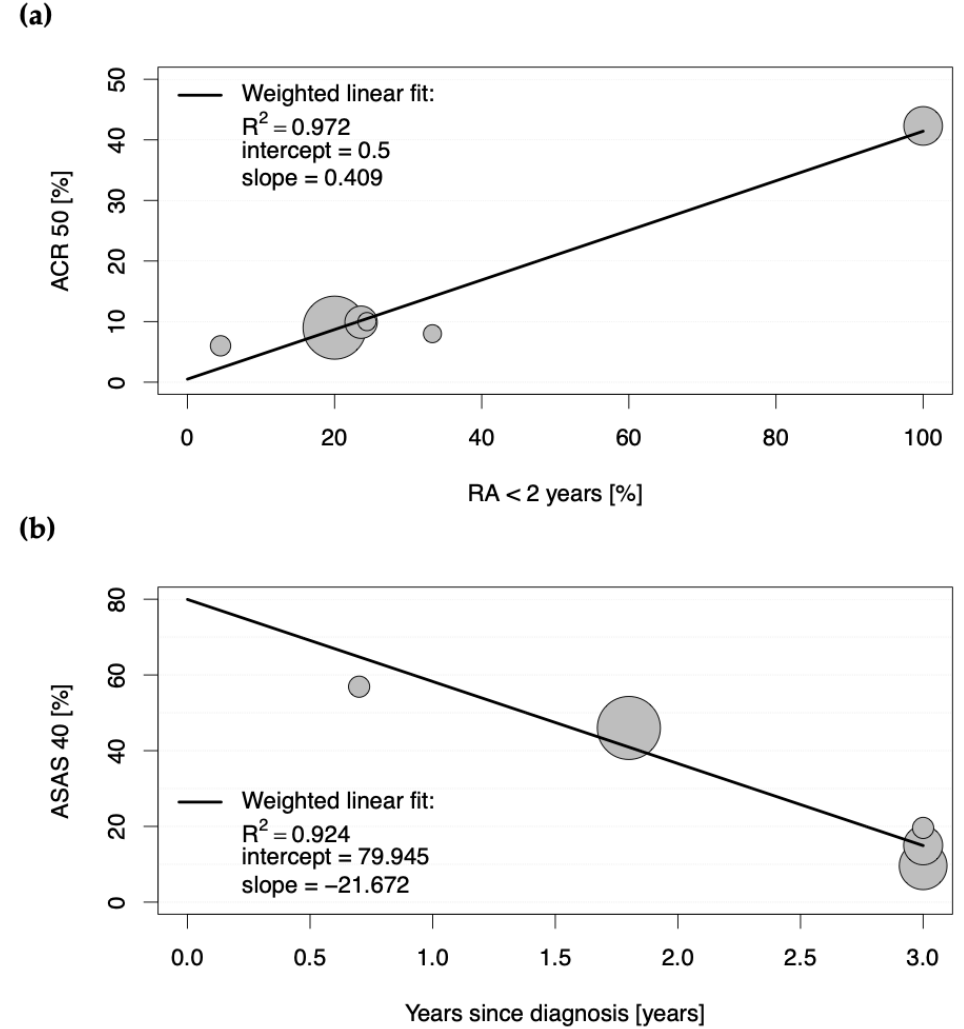
Figure 2. Scatter plots showing the positive weighted Pearson correlation between proportions of patients with ( a ) rheumatoid arthritis (RA) achieving American College of Rheumatology score 50 (ACR50) and proportions of patients with less than a two-year duration of RA in the placebo groups, and with ( b ) axial spondyloarthritis achieving Assessment of Spondyloarthritis International Society 40 (ASAS40) response in the placebo groups of eligible studies and duration of years since diagnosis. Each circle represents the study size for an individual placebo group.